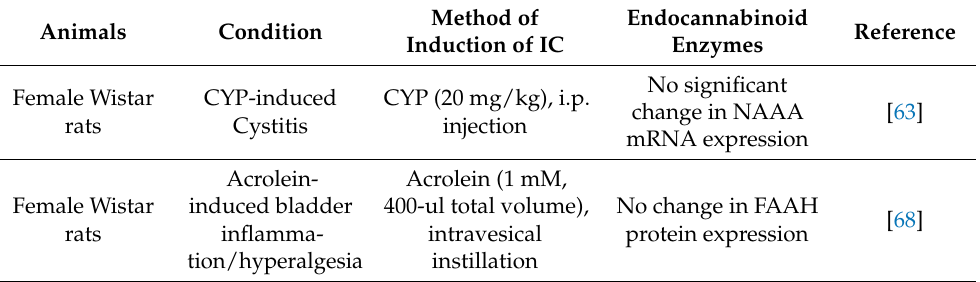
Table 3. Endocannabinoid Enzymes in the Bladder Tissue of Experimental IC/BPS Models. Method of Animals Condition Induction of IC